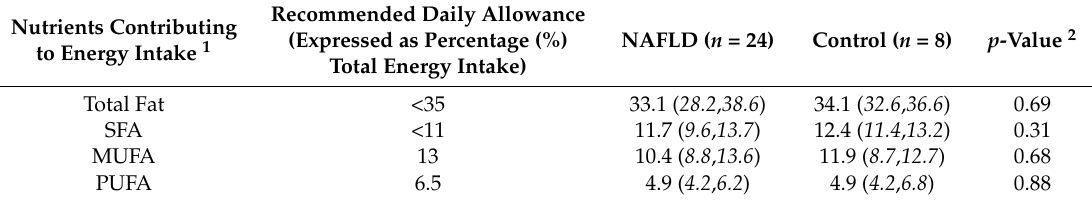
Table 3. Percentage of energy derived from total fat, SFA, MUFA and PUFA recorded via participant completed 7-day food